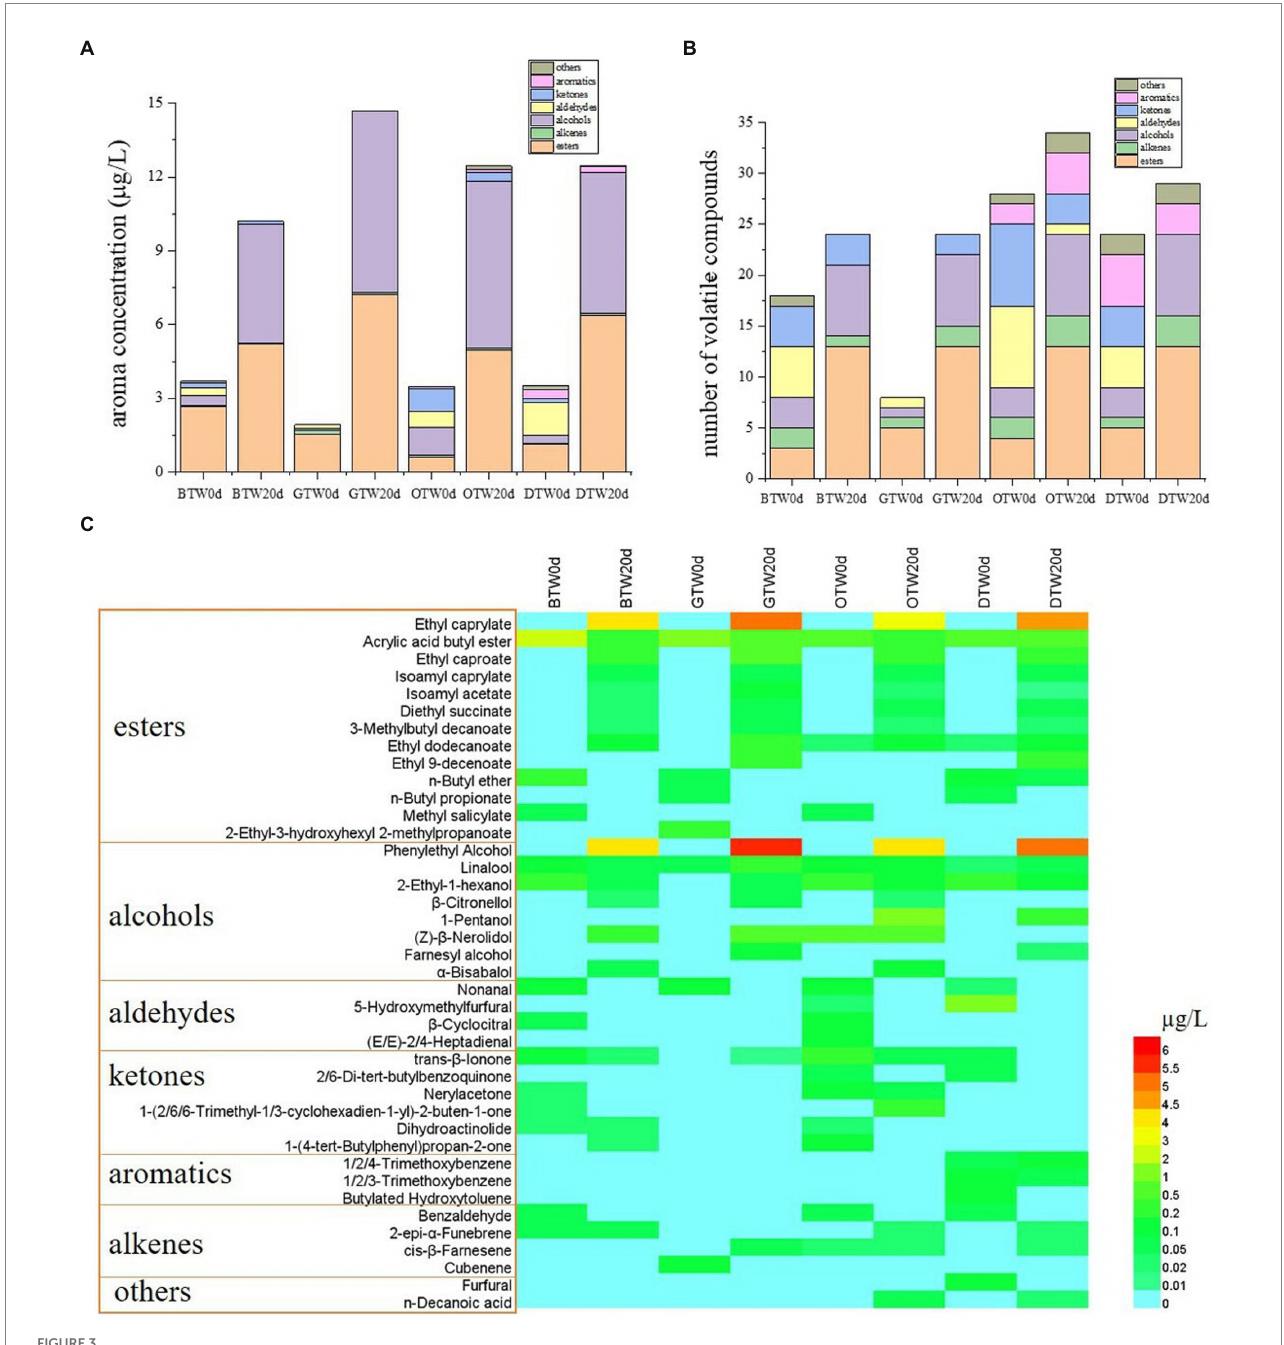
FIGURE 3 The aroma concentration (A) , the number of volatile compounds (B) , and the heatmap (C) of tea